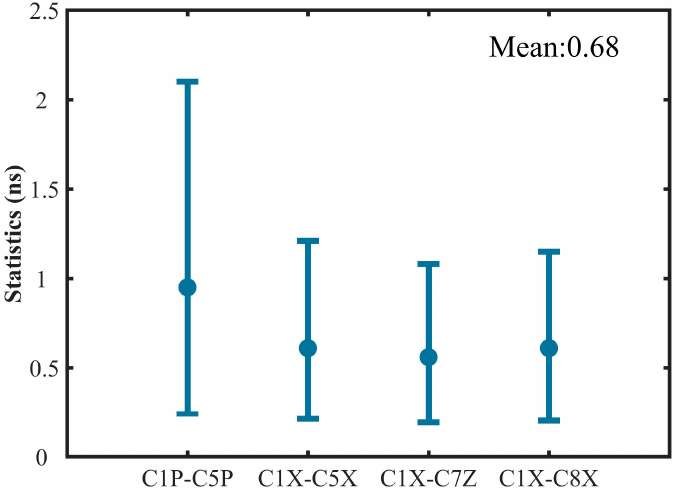
Figure 10. Statistics for RMS error of the estimated BDS-3 receiver DCBs with respect to the products provided by CAS during the period of DOY 60–89 in 2021.